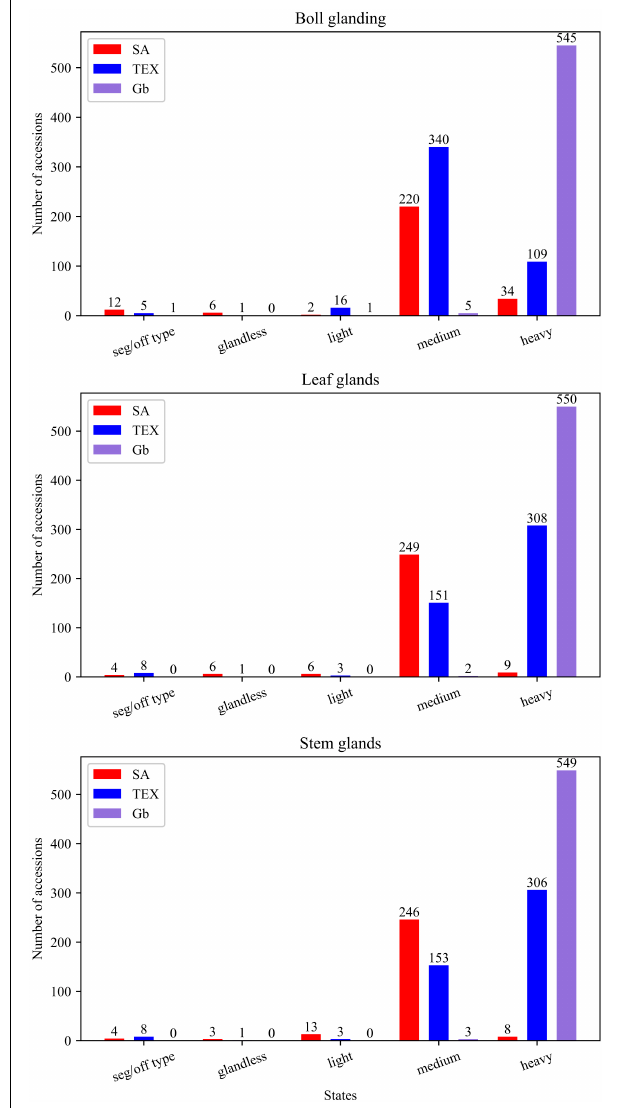
FIGURE 3 | Distribution of gland-related descriptors across plant structures and species. Seg/off type: segregation-off type condition, in which an accession was not homogeneous for a single